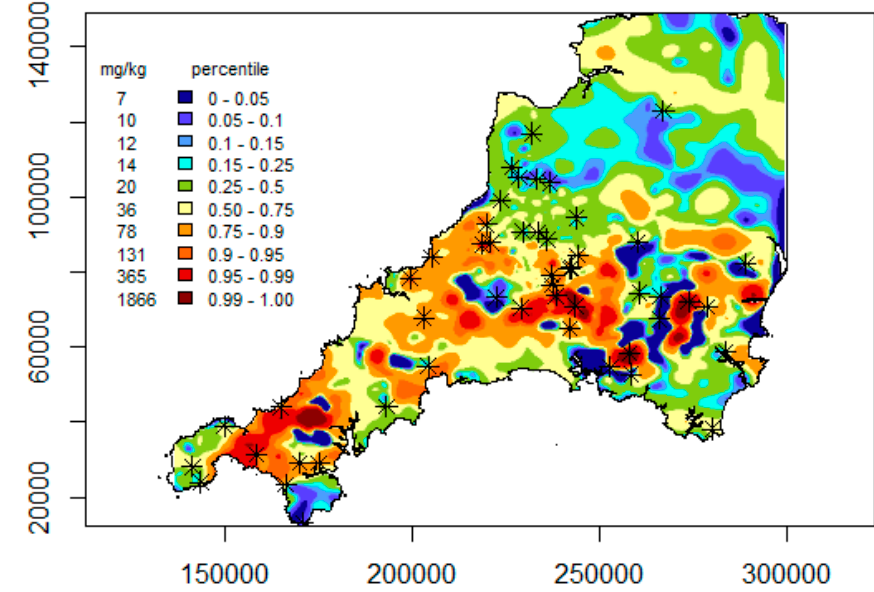
Figure 3. Interpolated map of total XRFS As in soils in south-west England with locations of the samples chosen for bioaccessibility testing. (x-axis is EASTING, y-axis is NORTHING).